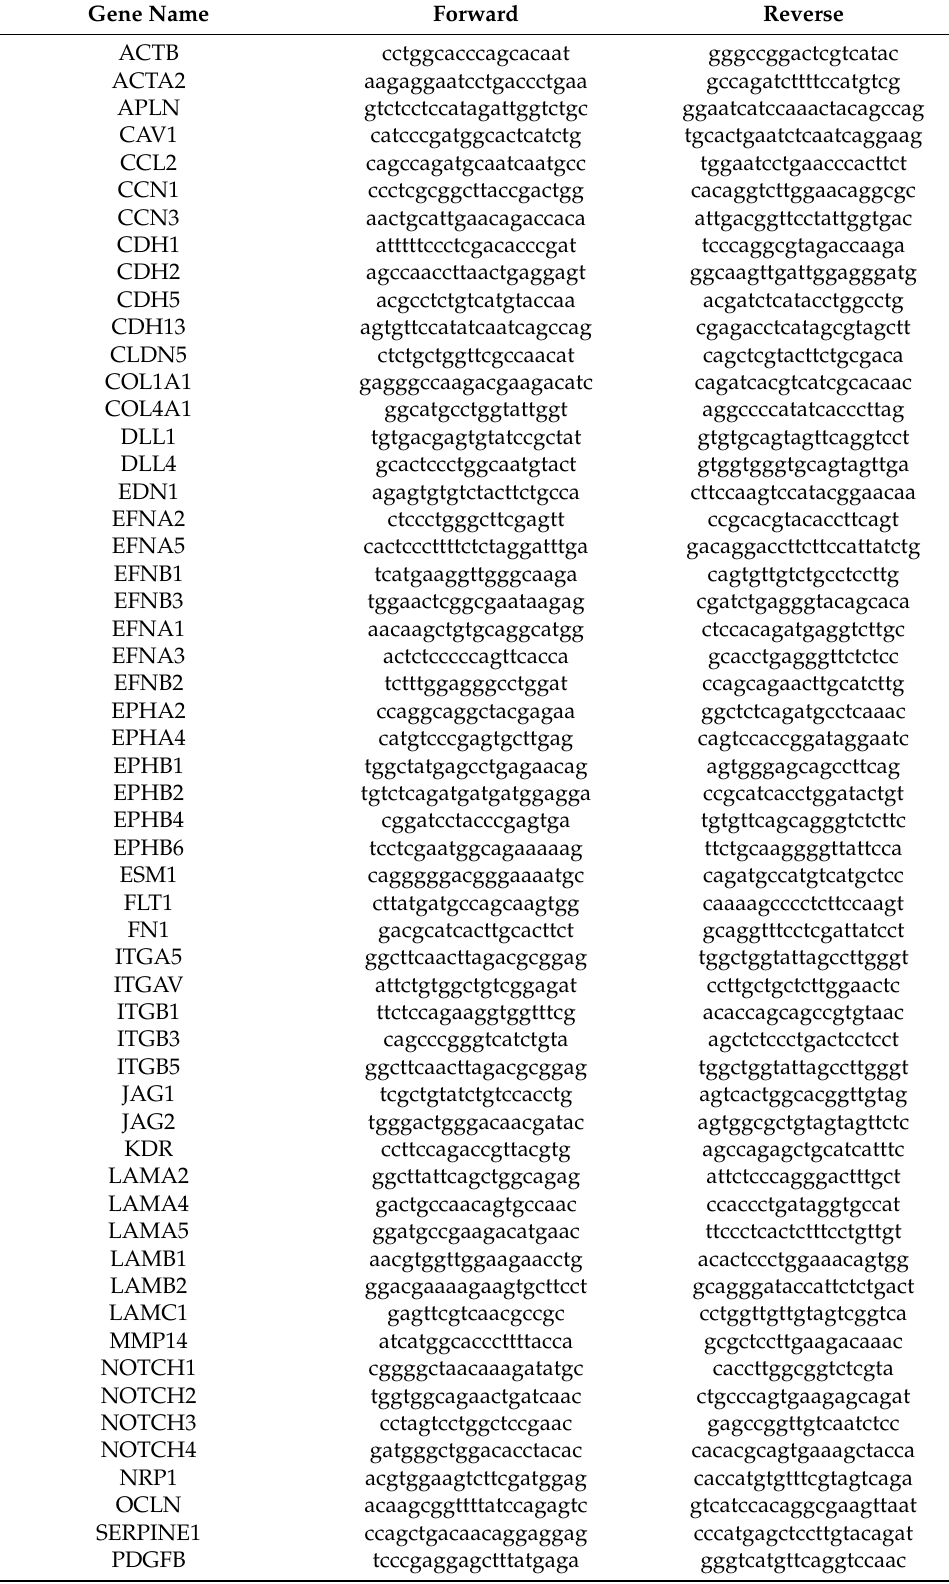
Table 1. List of PCR primers